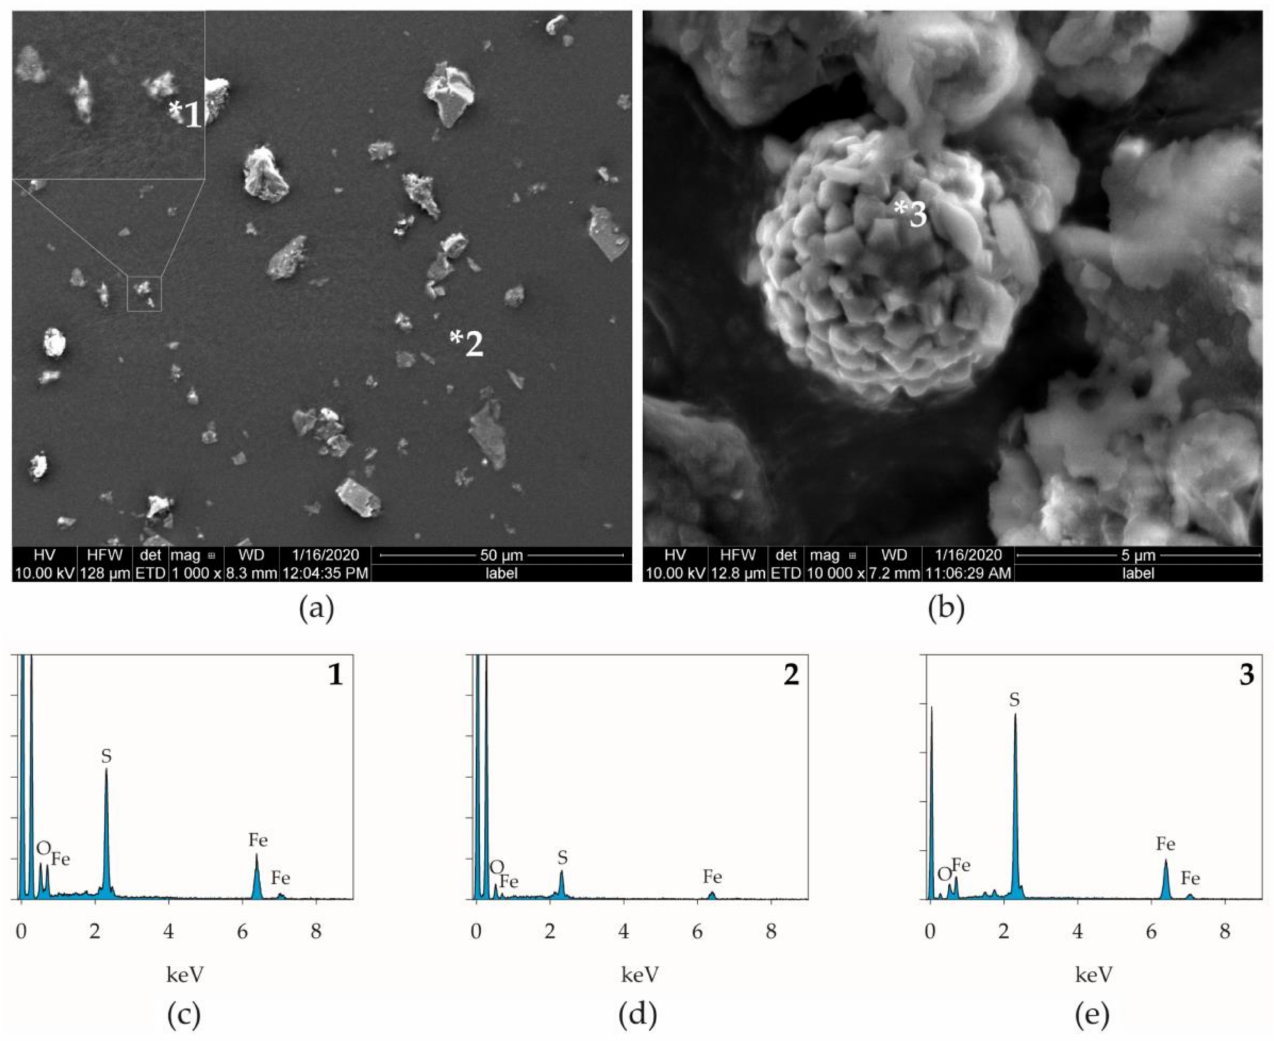
Figure 7. SEM photomicrographs of pyrites found in mangrove soils from CE-7Y (* represents the exact surface from where the EDS spectra were obtained) ( a ) and CE-MM ( b ) and their correspond- ing EDS spectra ( c – e ). In CE-7Y ( a ), the SEM-EDS photomicrographs revealed arrangements of poorly crystalline isolated authigenic euhedral pyrites. Contrastingly, in CE-MM, the SEM-EDS photomicrographs revealed the presence of authigenic framboidal